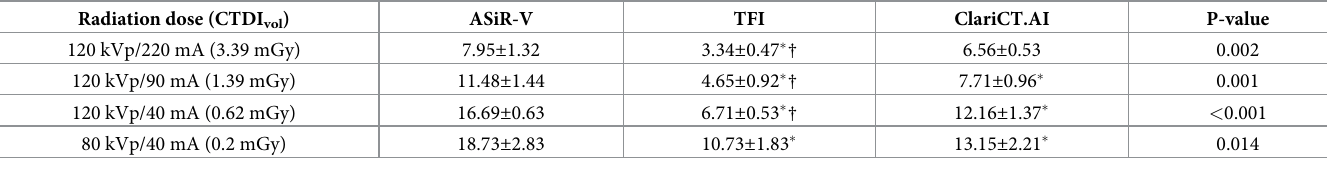
Table 6. Comparison of image noise values of different algorithms. Radiation dose (CTDI vol